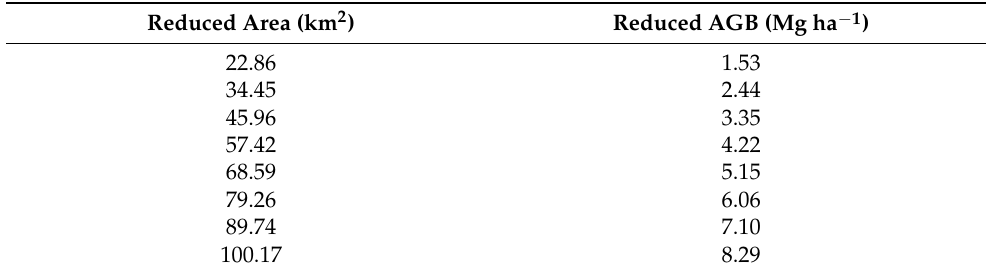
Table 5. Relationship between degraded area of wetland and forest accumulation reduction